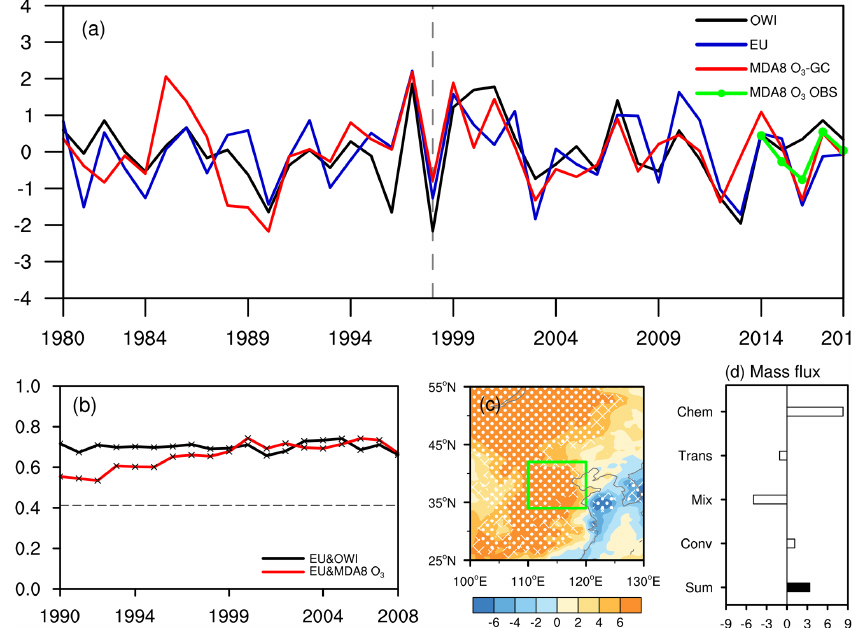
Figure 1. (a) The normalized variation in JJA-mean OWI (black), EU index (blue), simulated MDA8 O 3 (red) from 1980 to 2018 and observed MDA8 O 3 (green) from 2014 to 2018 after detrending. (b) The 21-year sliding correlation coefficients between simulated MDA8 O 3 (red), OWI (black) and EU. The black dotted line (crosses) indicates (exceeded) the 95% confidence level. (c) Composite difference of the simulated MDA8 O 3 (unit: µgm − 3 ) in summer between the six highest and the six lowest EU index years from 1980 to 2018. The white dots (hatching) indicate that the difference was above the 95% (90%) confidence level ( t test). The green box represents the location of North China. (d) Composite difference of the mass fluxes of summer ozone (unit: td − 1 ) from GEOS-Chem between the six highest and the six lowest EU years from 1980 to 2018. The left axis gives the names of the physicochemical processes: chemical reaction (Chem), transport (Trans), PBL mixing (Mix), convection (Conv) and their sum (Sum).